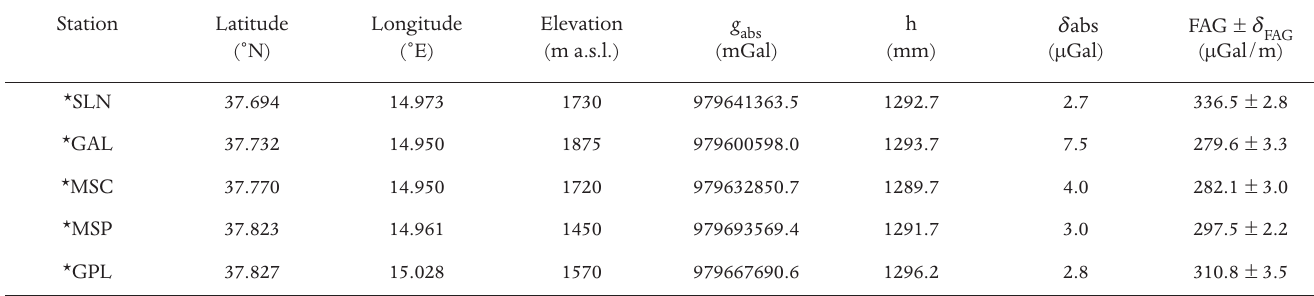
Table 1. Results of absolute gravity measurements acquired in 2010 using a FG5#238 gravimeter. The first four columns give the acronyms and the coordinates of the absolute gravity stations (the locations of the sites are mapped in Figure 1). The last four columns give their measured gravity values ( g ) referred to the height ( h ), the total uncertainty ( d abs absolute reference